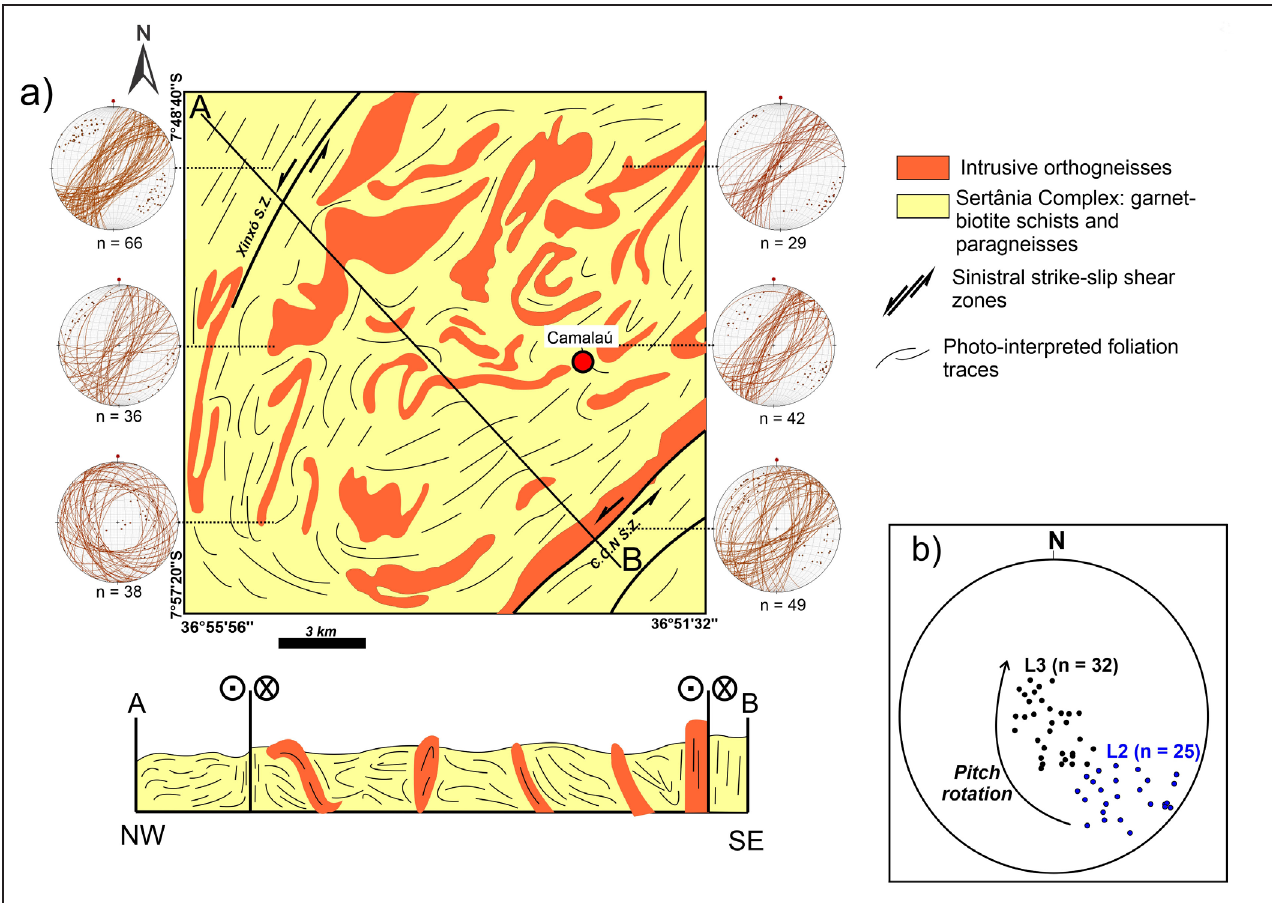
FIGURE 2 - Simplified geological map of the studied area showing the foliation traces and structural and plotted foliation planes on distinct sectors of the studied area; b) Stereogram showing the variation of the mineral stretching lineations (L strike-slip regimes. Stereograms are equal area (lower hemisphere),